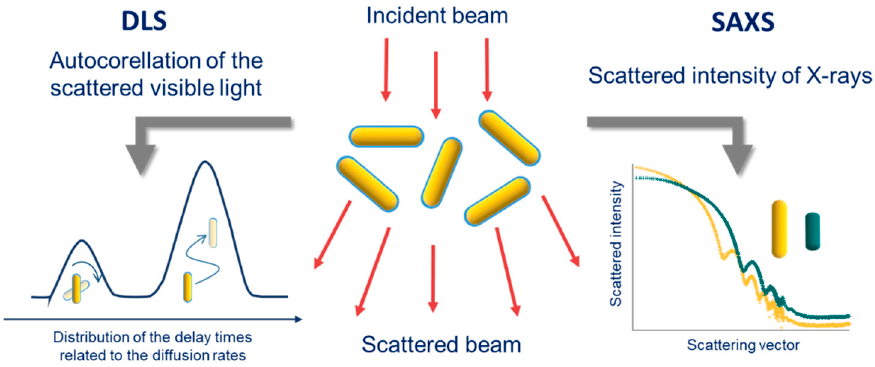
Figure 14. Scattering techniques commonly used to characterize AuNRs.